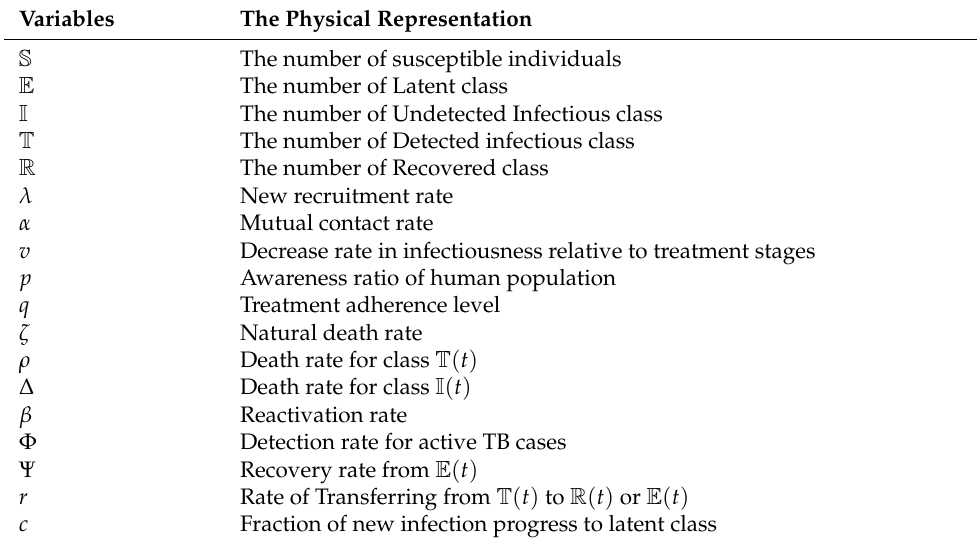
Table 1. The parameters of the model (1) and their